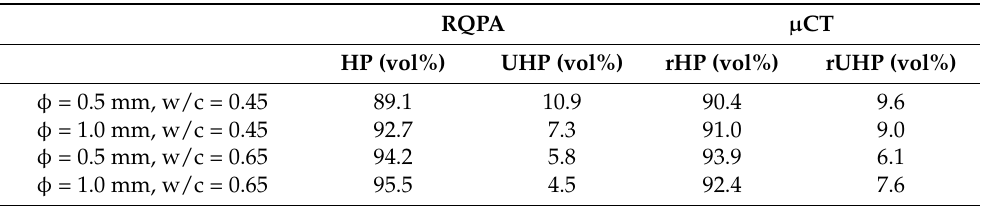
Table 4. Comparison of the RQPA analysis results, grouped in the two sets of components, with those derived from µ CT. RQPA µ CT HP (vol%) UHP (vol%) rHP (vol%) rUHP